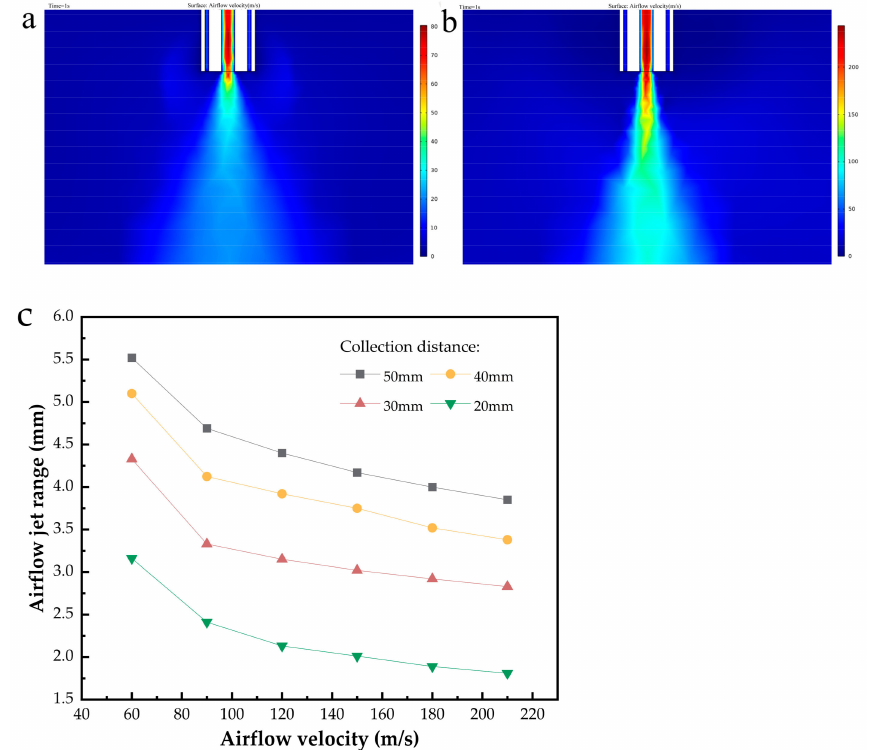
Figure 4. ( a , b ) Simulation diagram when the high-speed airflow is 60 m/s and 210 m/s, respectively. ( c ) Airflow diffusion range under different